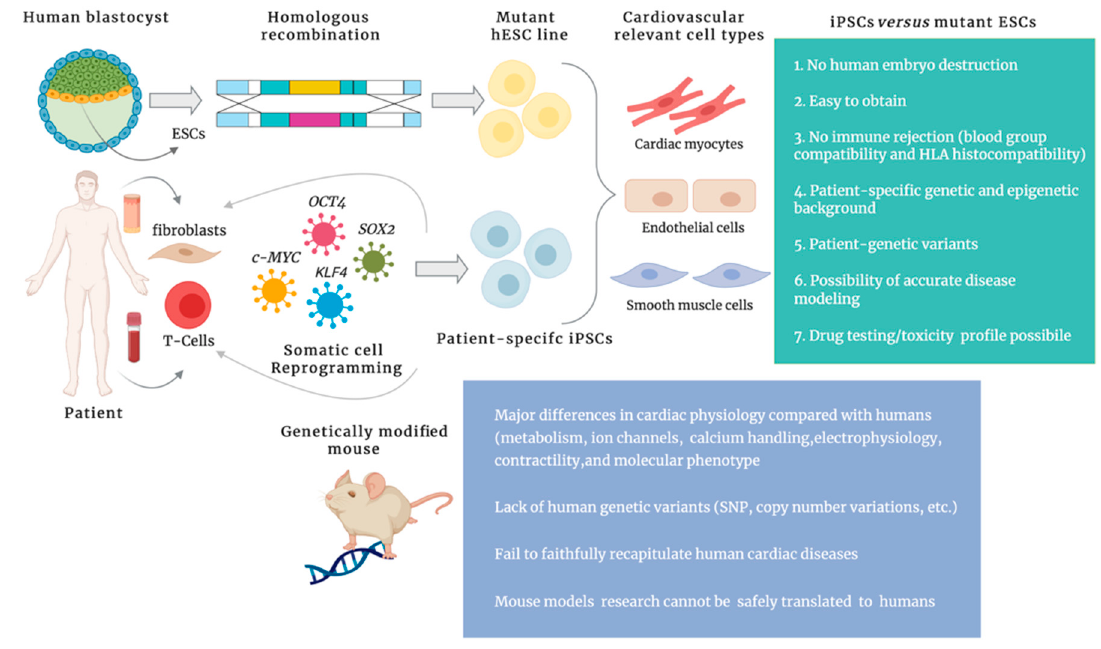
Figure 1. Advantages of induced pluripotent stem cells (iPSCs) over mutant embryonic stem cells(ESCs) and genetically modified mouse models.